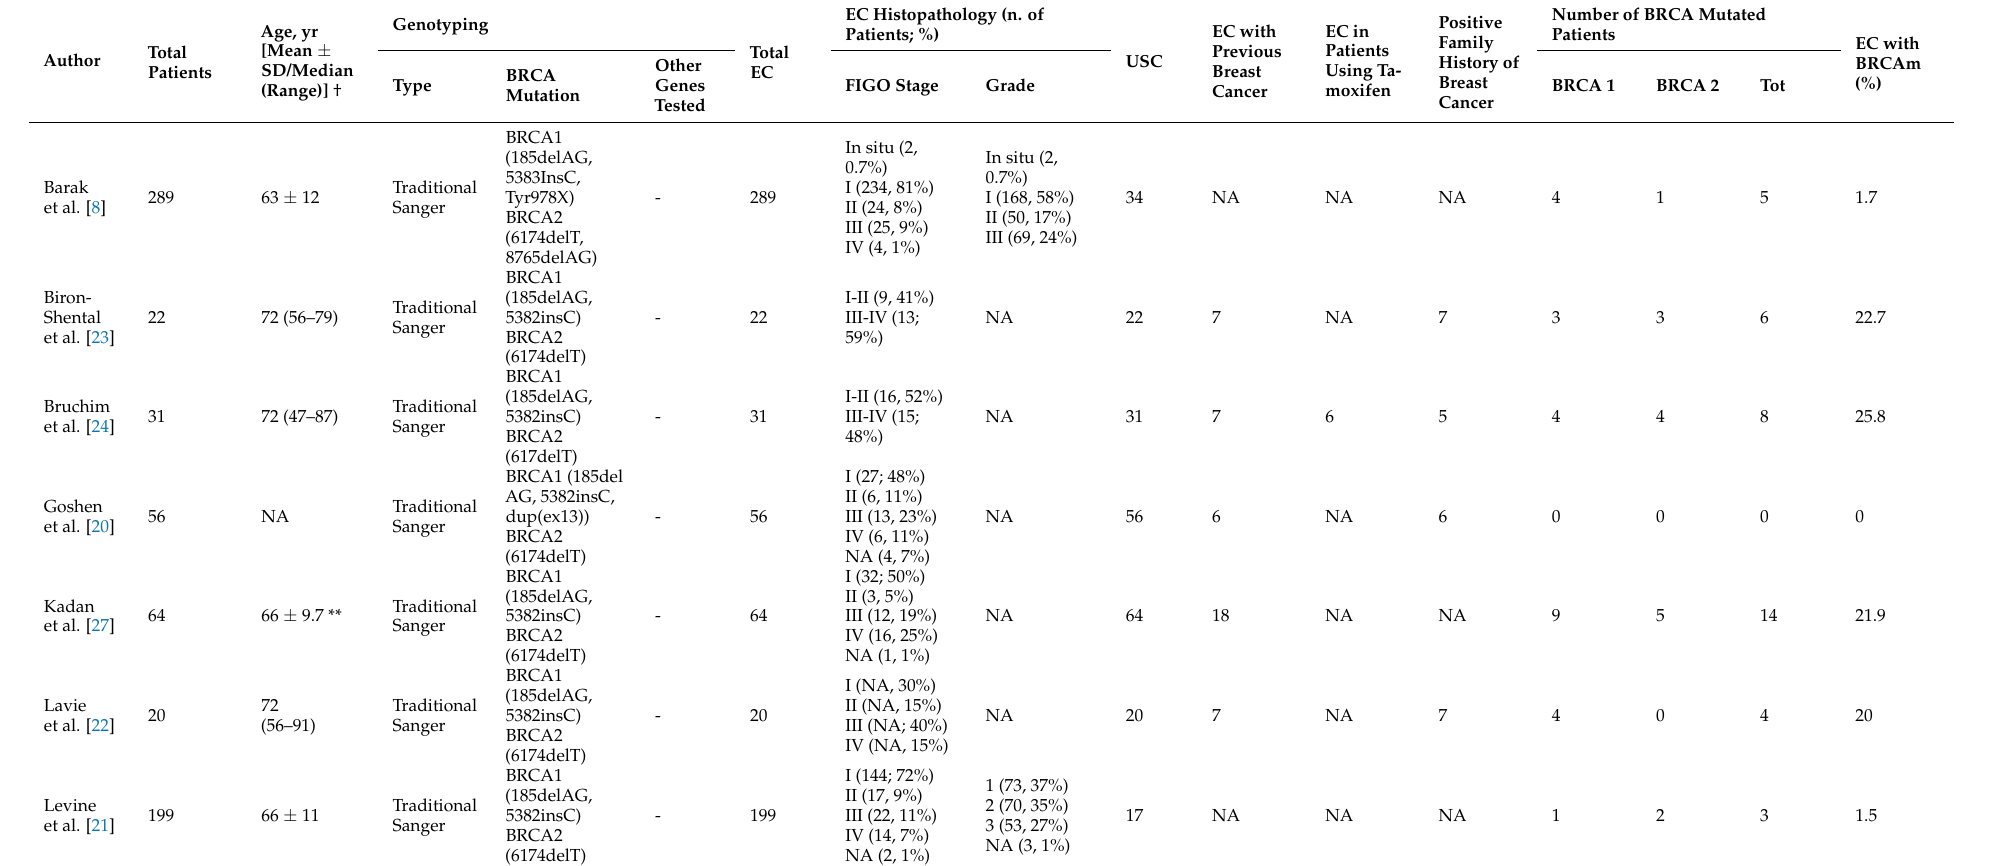
Table 4. Main findings of the included studies on the prevalence of BRCAm in patients with endometrial